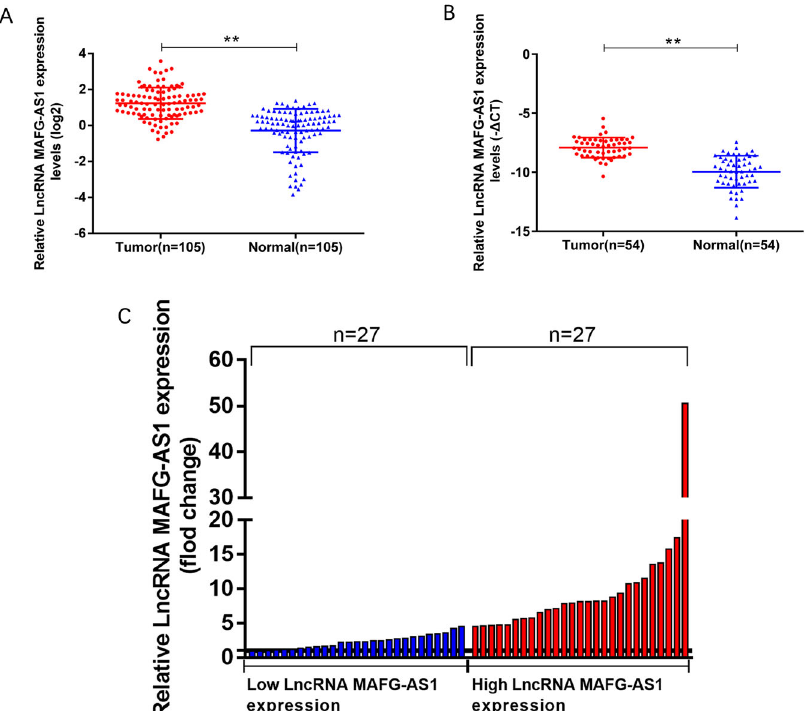
Fig. 1 Relative expression of LncRNA MAFG-AS1 in BC tissues. A Data collected from TCGA database showed relative expression of LncRNA MAFG-AS1 in BC tissues ( n = 105) and their corresponding nontumorous tissues ( n = 105). B , C Relative LncRNA MAFG-AS1 expression in BC tissues ( n = 54) compared with their adjacent normal breast tissues analyzed by qRT-PCR and tissues were divided into two groups according to the fold-change of LncRNA MAFG-AS1 expression. * P < 0.05, ** P <